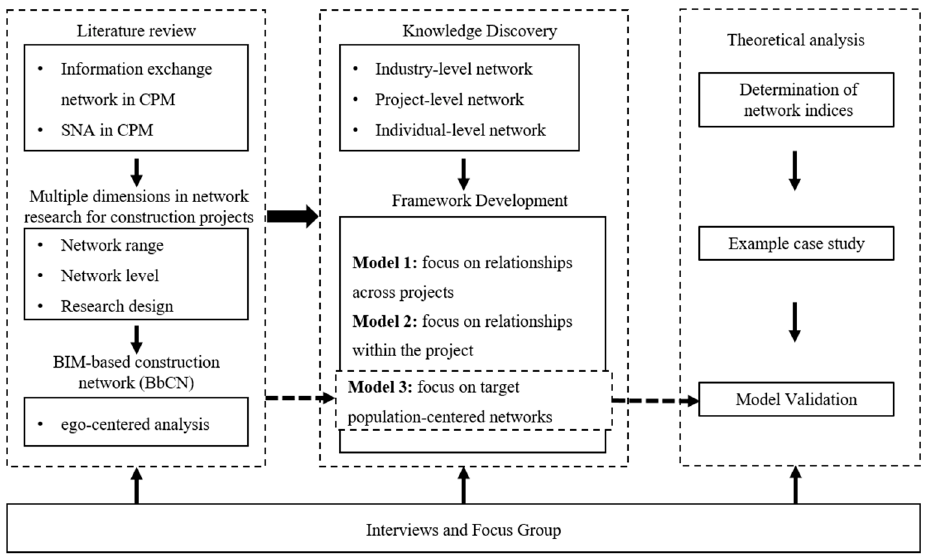
Figure 3. The methodology